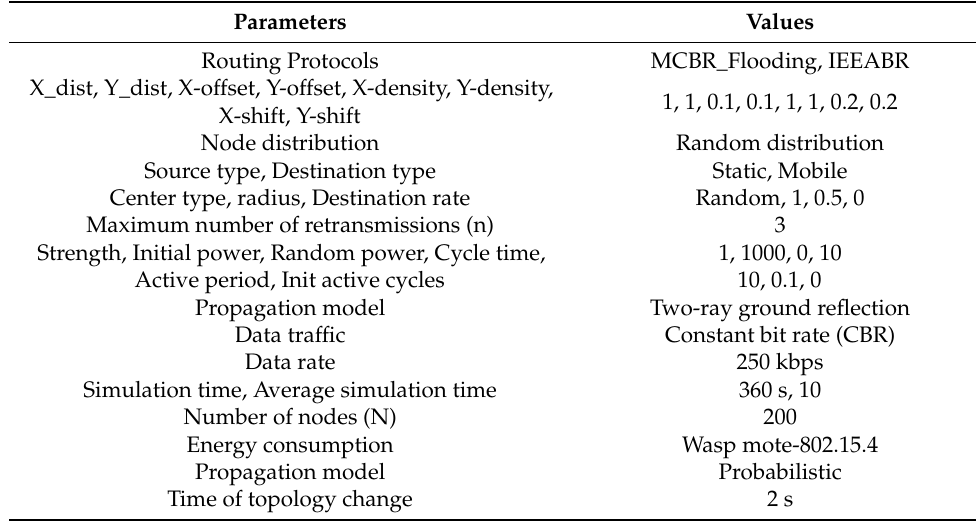
Table 4. Simulation